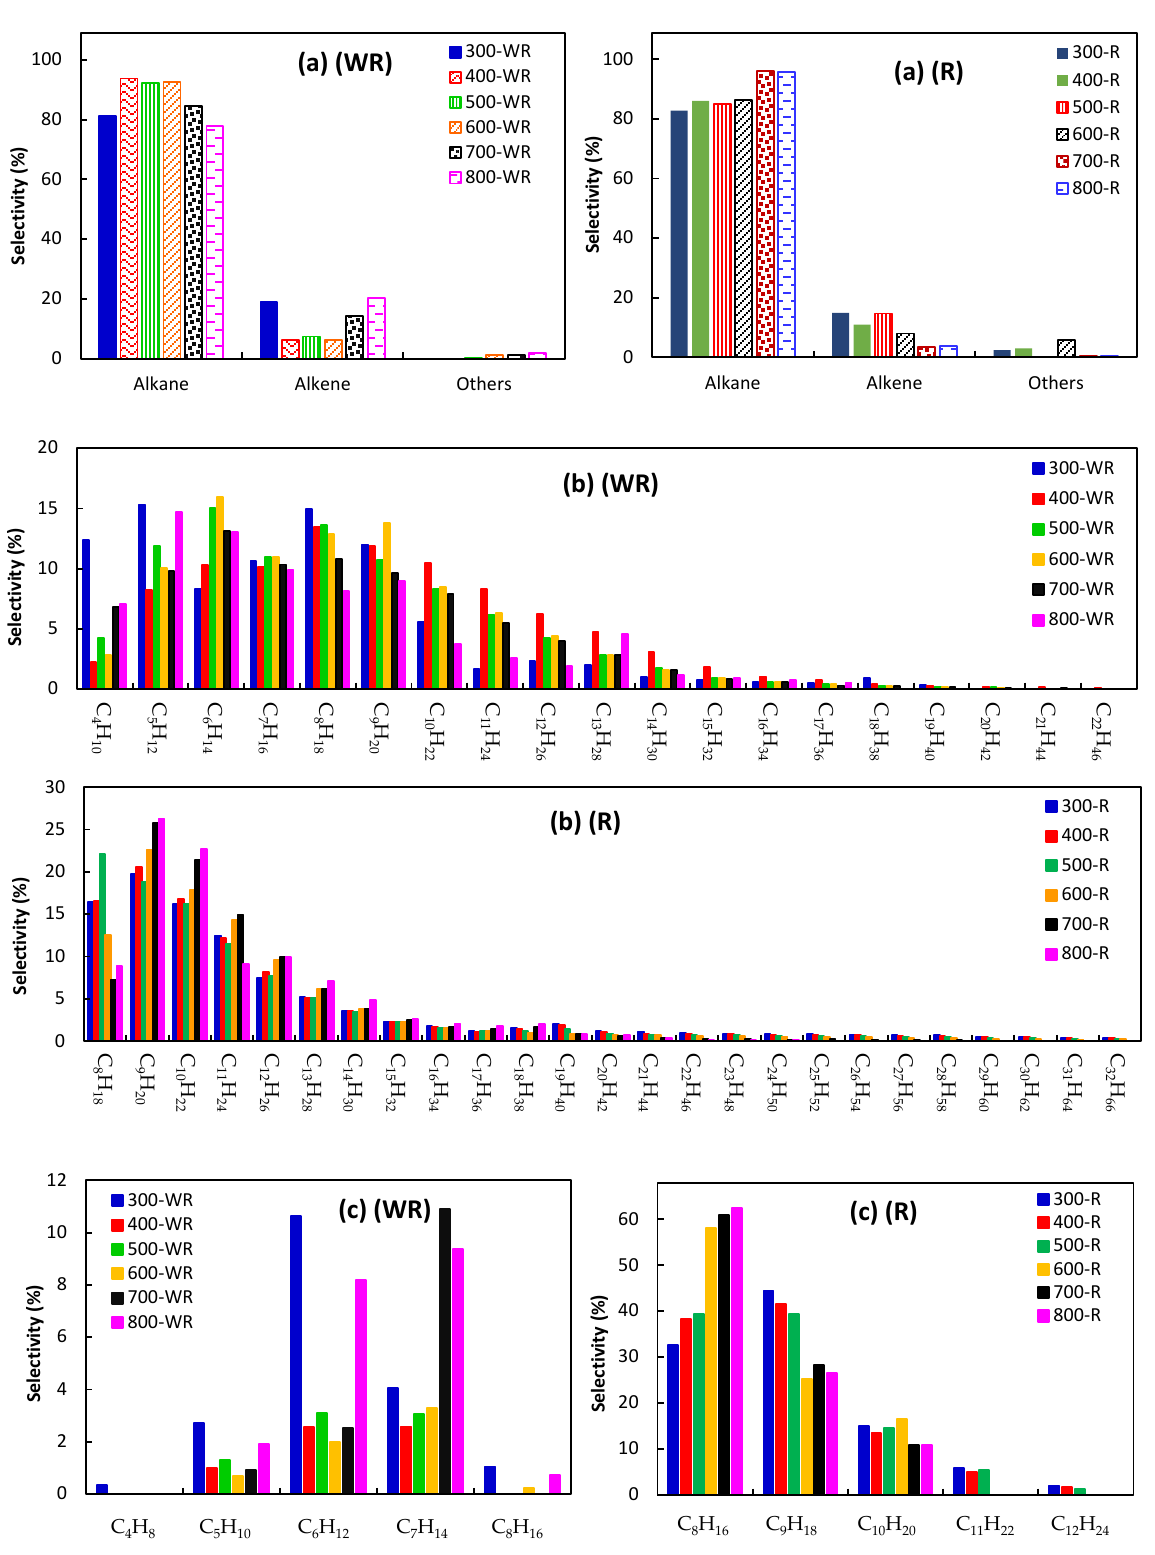
Figure 7. ( a ) Product distribution in liquid phase products, ( b ) distribution of n-alkanes, and ( c ) alkenes in the liquid phase products (WR: without reduction step, R: with reduction step).